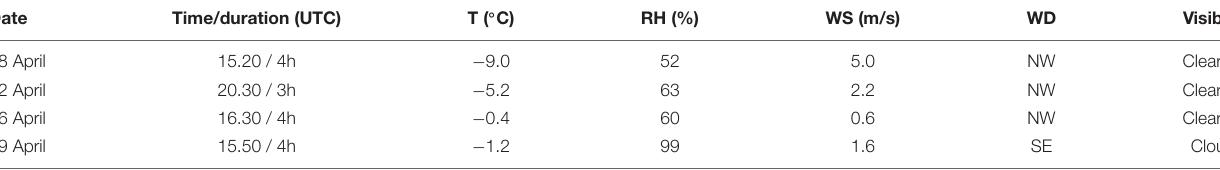
TABLE 3 | Characteristics (time and duration) and environmental conditions of aerosol